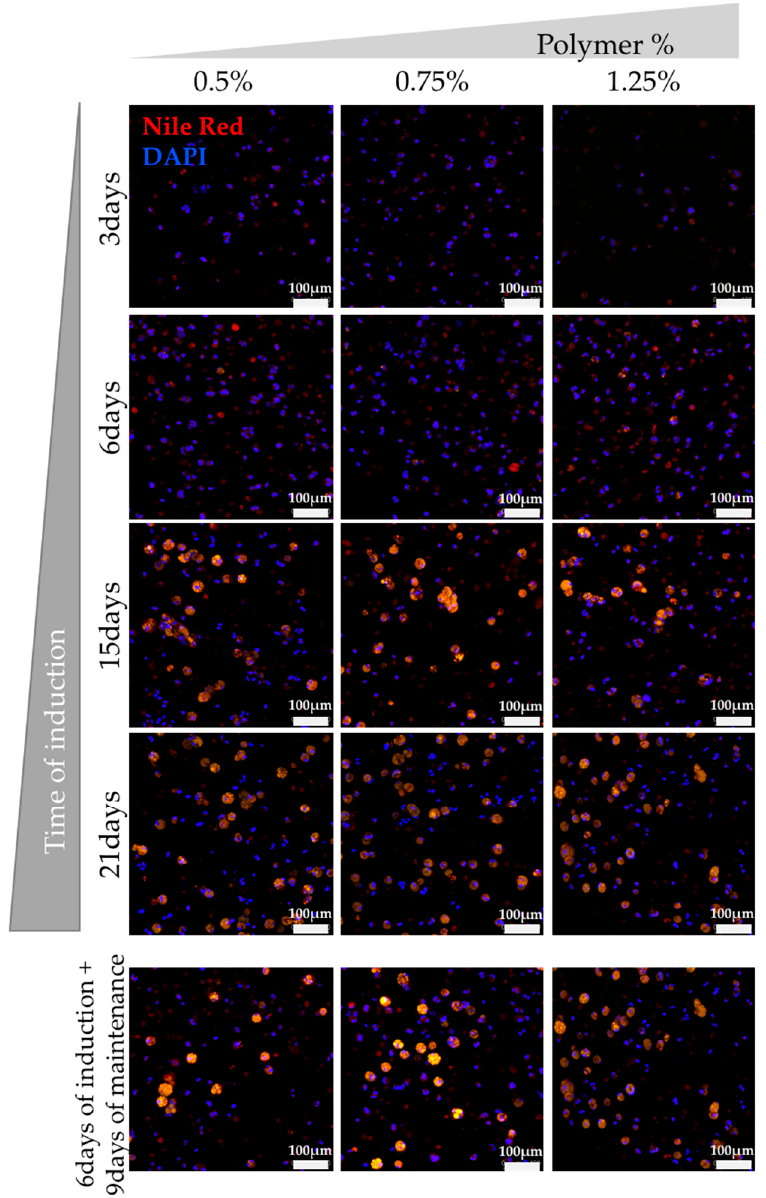
Figure 5. Neutral intracellular lipids accumulation in human adipose-derived stem cells-derived adipocytes within gellan gum hydrogel particles with different amounts of polymer along the culture in adipogenic induction medium and after being cultured for six days in induction plus nine days in maintenance media. Representative confocal images of cells stained with nile red (yellow). Nuclei were labelled with DAPI (blue). Polar cell membrane lipids are stained in red. Scale bar 100 µm.